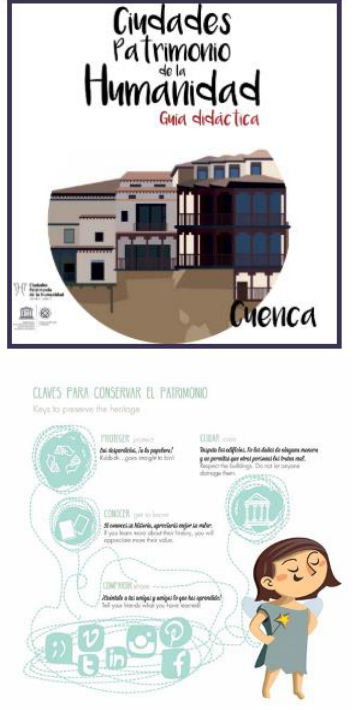
Figure 2. Publication for children on the city of